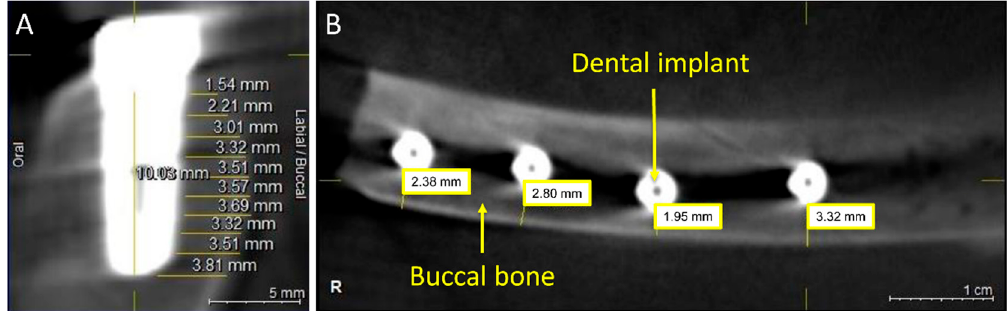
Figure 9. CBCT image of a dental implant and measurement points in the sagittal ( A ) and horizontal ( B ) view.